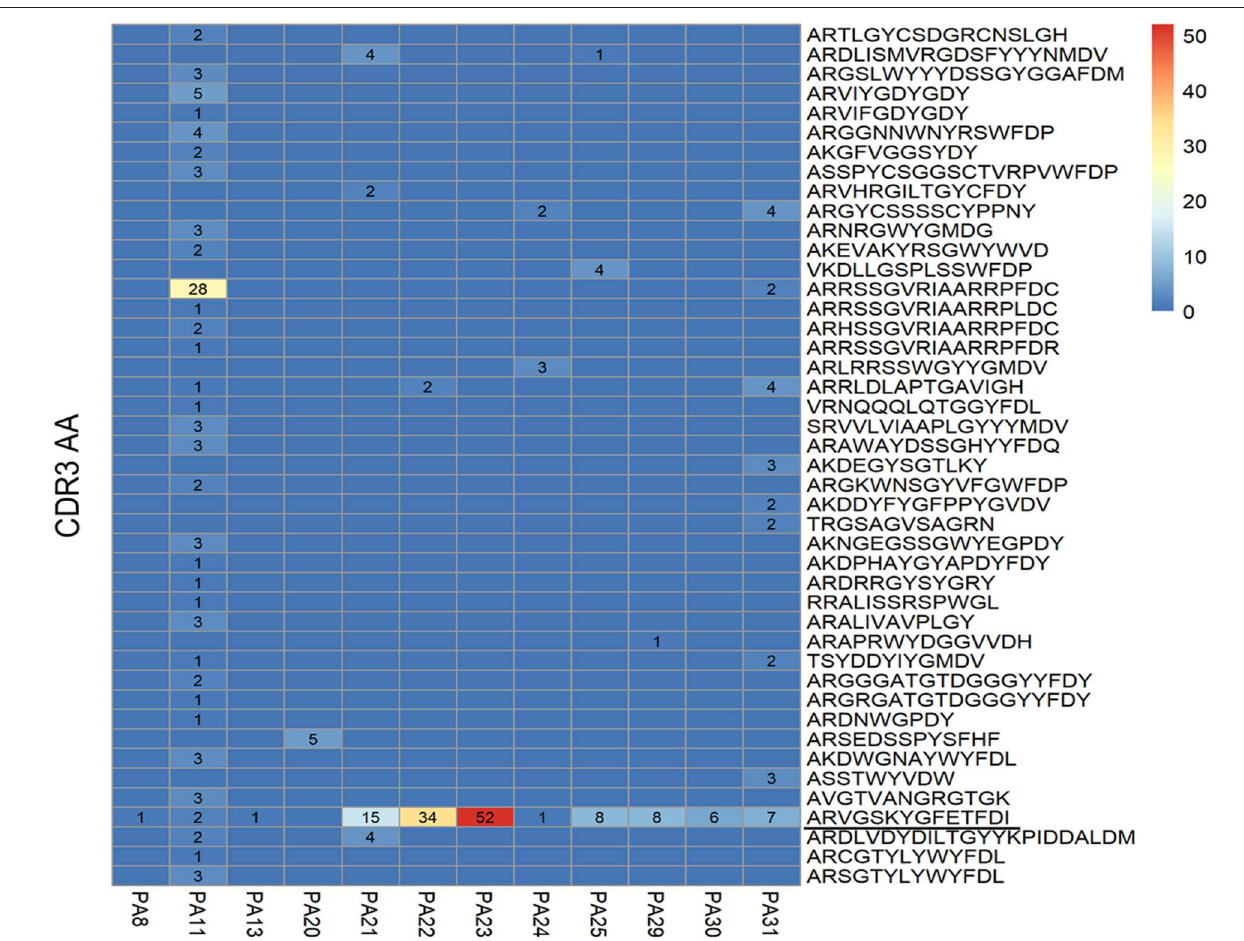
chain common clone was confirmed as IgG1 in